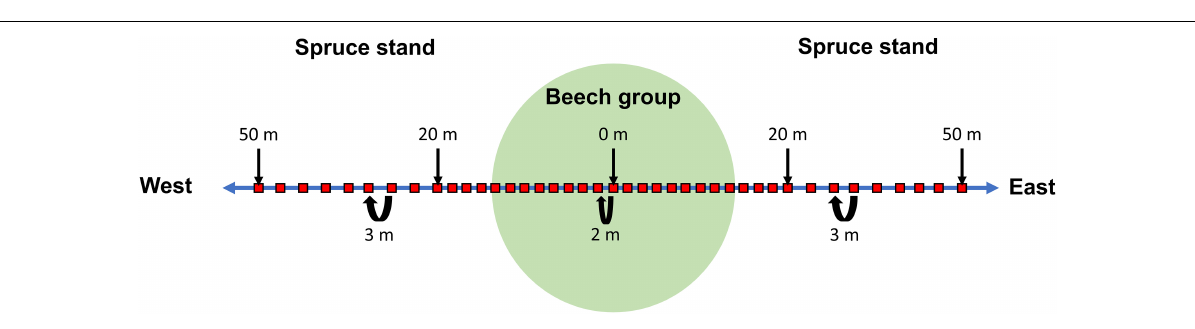
FIGURE 2 | Experimental design for humus measurements along an east-west